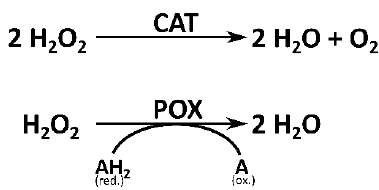
Figure 1. Schematic representation of the reactions of hydrogen peroxide (H 2 O 2 )-scavenging en- zymes catalase (CAT) and peroxidase (POX). CAT does not require an electron donor for the con- version of H 2 O 2 into water (H 2 O) and oxygen (O 2 ). POXs use a range of molecules as